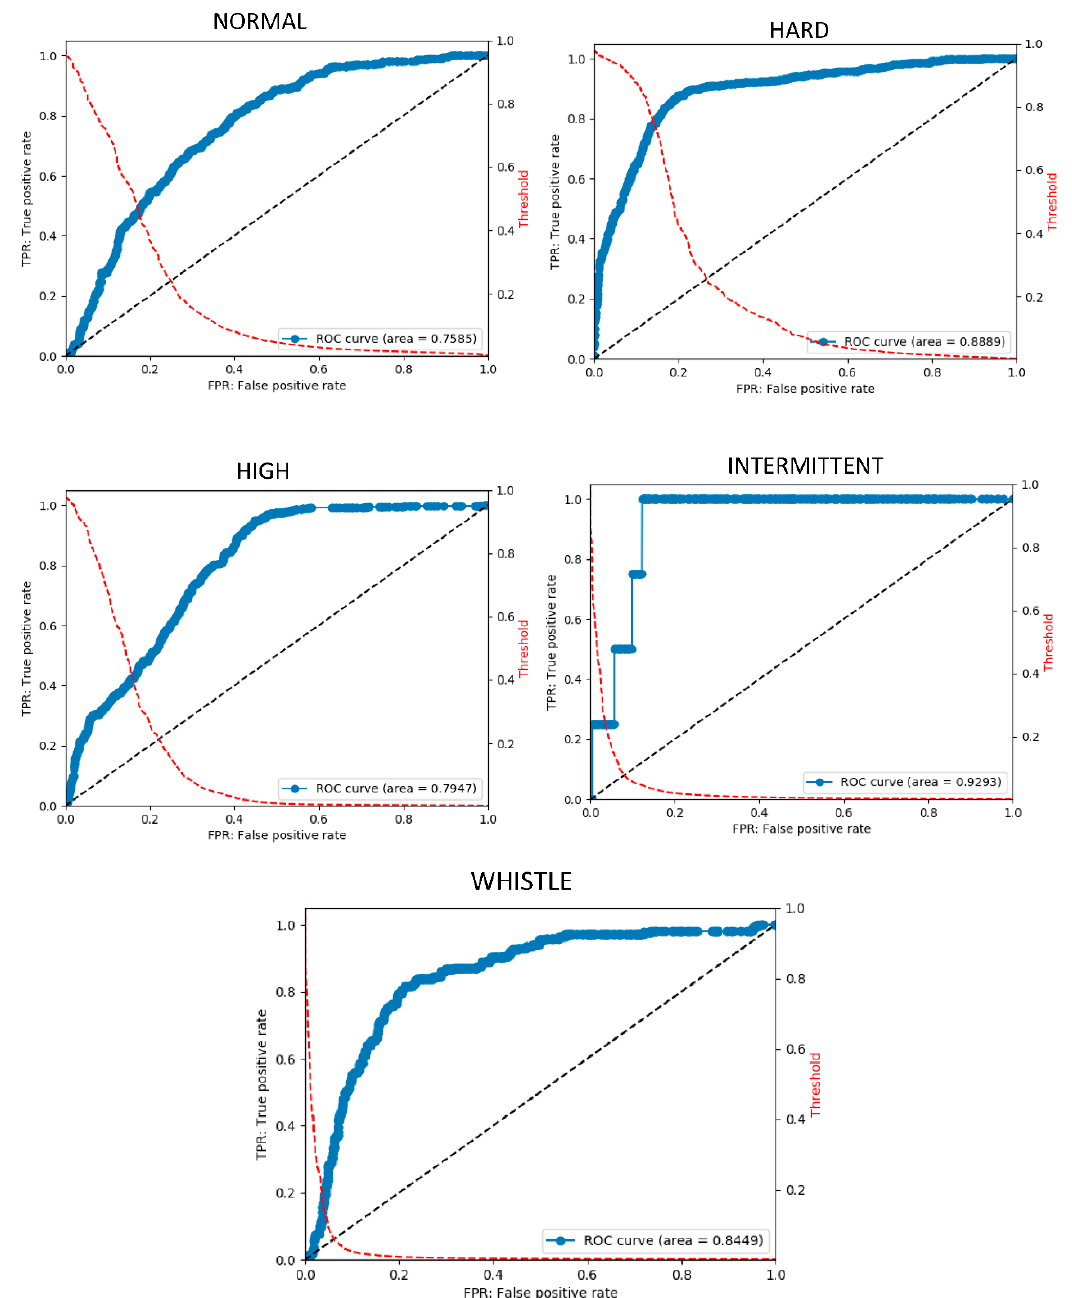
Figure 4. Final ROC curve obtained using the final stage model. The ROC curve is obtained by changing the threshold and plotting the true positive rate (TPR) at each threshold on the vertical axis and the false positive rate (FPR) on the horizontal axis. The ROC curve is on the blue line. The red dotted line shows the curve for obtaining the FPF at each threshold. It can be observed that, by changing the threshold, the threshold can be adjusted to lower FPR to detect rare diseases.